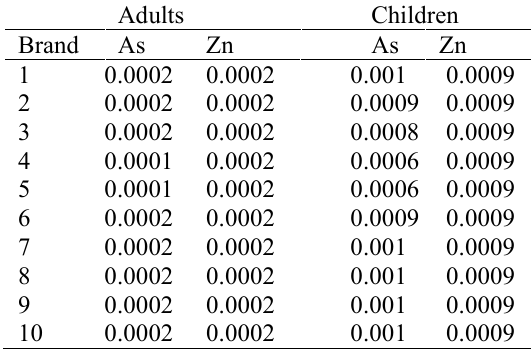
Table 2. Daily intakes of metals (DIM, mg) for ndividual